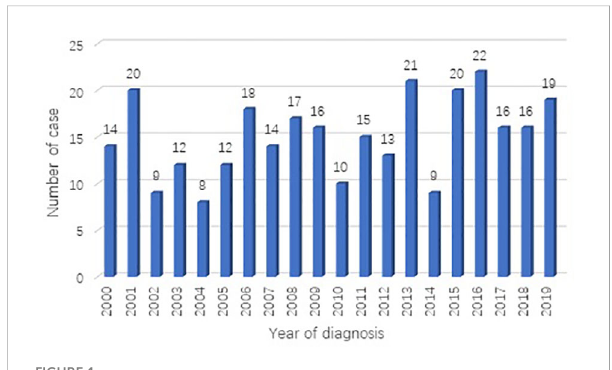
FIGURE 1 Number of primary lung cancer diagnosed each year from 2000 to 2019 in SEER database.